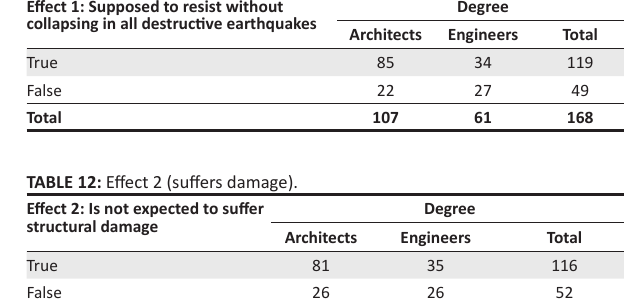
TABLE 8: Objective 3 of seismic rules (guarantee that the building do not collapse). Objective3: Guarantee the non-collapse of buildings